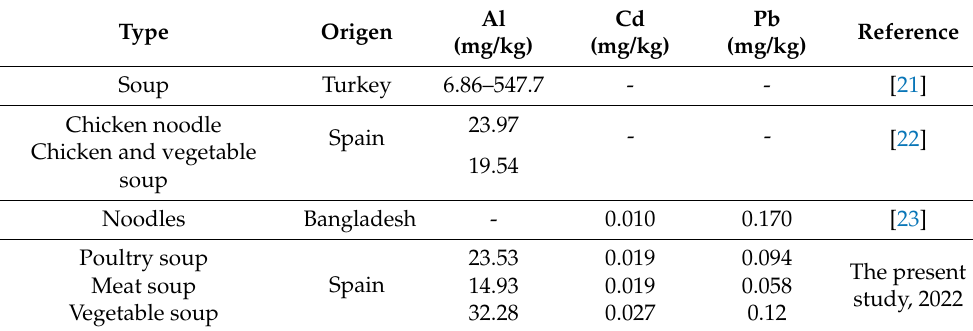
Table 5. Comparison of the contents of toxic metals (Al, Cd, and Pb) with results obtained by other